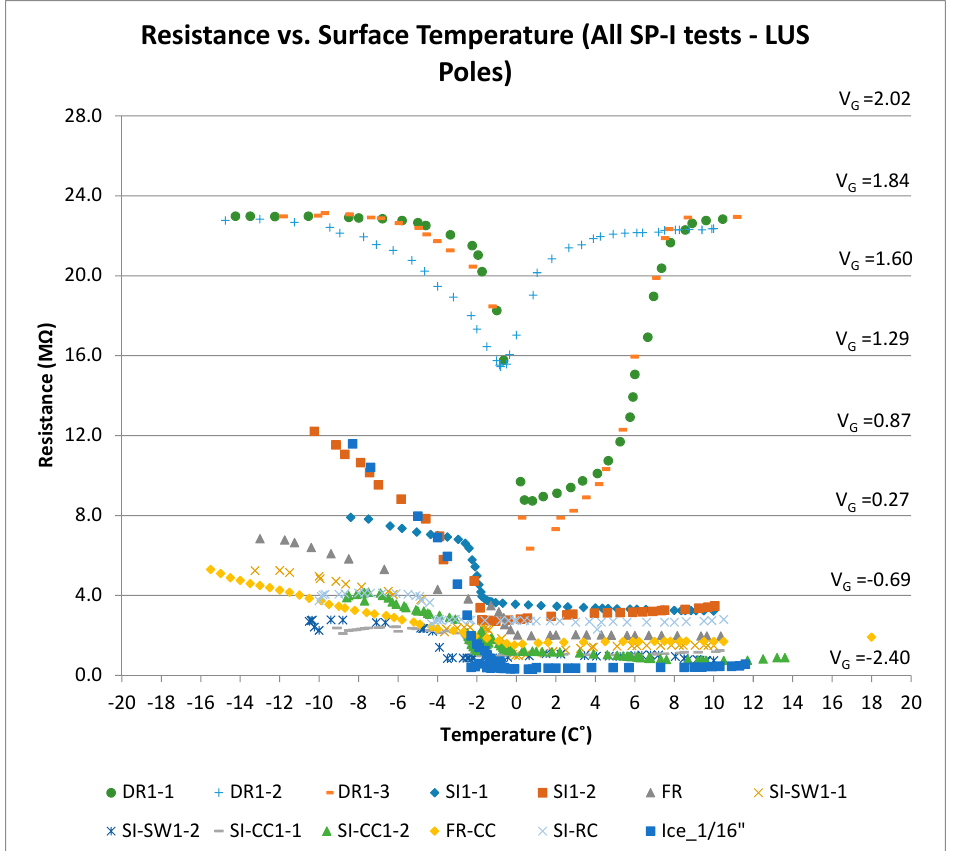
Figure 15. Resistance (and voltage) versus surface temperature for all SP-I prototype tests (LUS Poles).